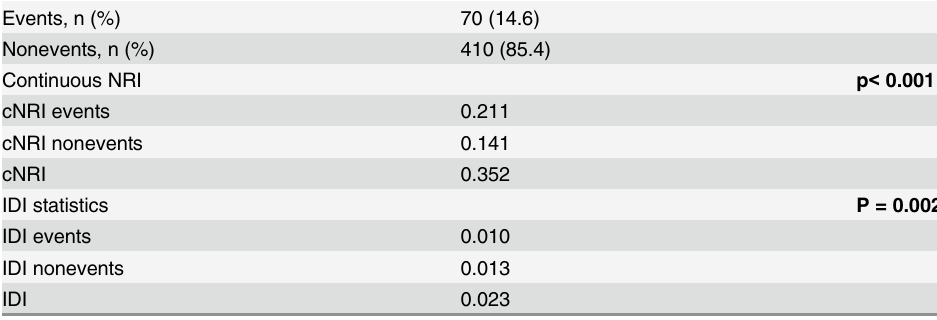
Table 5. Discrimination of model in predicting major adverse cardiovascular events